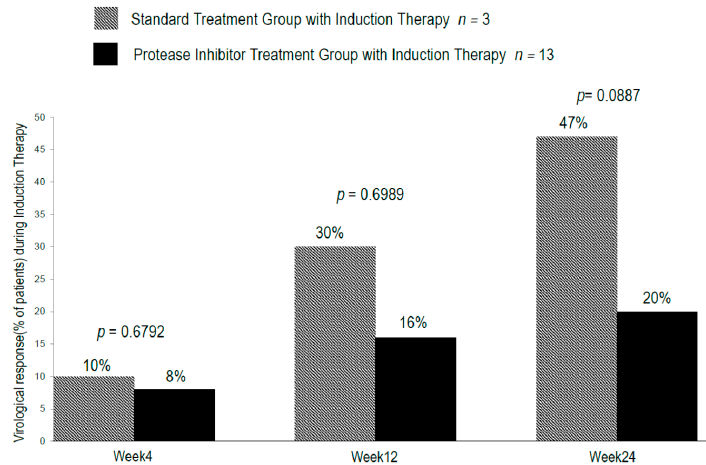
Figure 3. Rate of early virologic responses in the initial 4, 12 and 24 weeks in chronic hepatitis C patients with genotype 1b and high viral loads during induction therapy in standard treatment with induction therapy with n-IFN- β and protease inhibitor treatment with induction therapy with n-IFN- β . Virologic response was defined as undetectable serum level HCV.RNA (<15 IU/mL). The paired- t test was used to evaluate the differences of the means between two groups with a p -value of <0.05 considered significant.